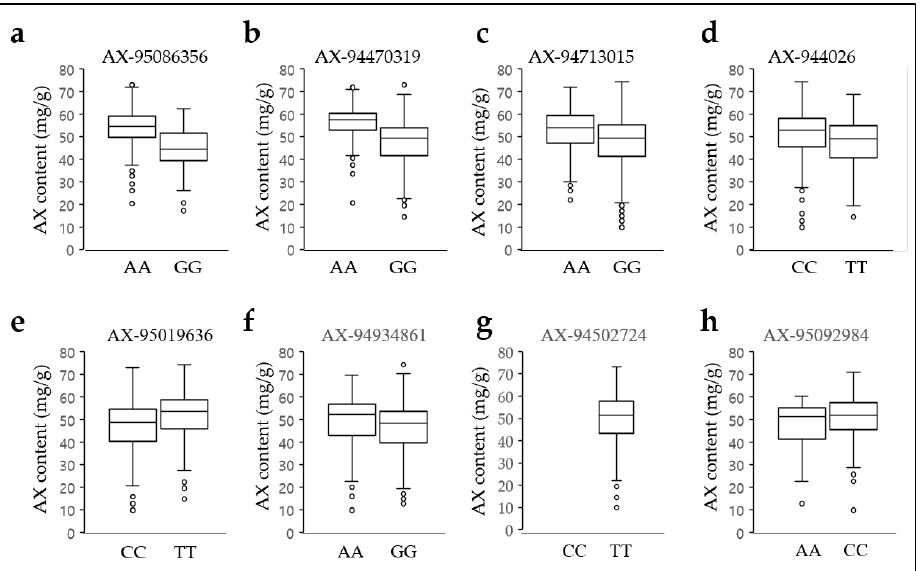
Figure 5. Arabinoxylan content of each allele in the eight SNPs. Arabinoxylan level in allele AX- 95086356 ( a ), AX-94470319 ( b ), AX-94713015 ( c ), AX_94534026 ( d ), AX-95019636 ( e ), AX-94934861 ( f ), AX-94502724 ( g ), and AX-95092984 ( h ). The X-axis depicts the two alleles, and the Y-axis represents the AX content. AX, arabinoxylan; A, adenine; C, cytosine; T, thymine; G,